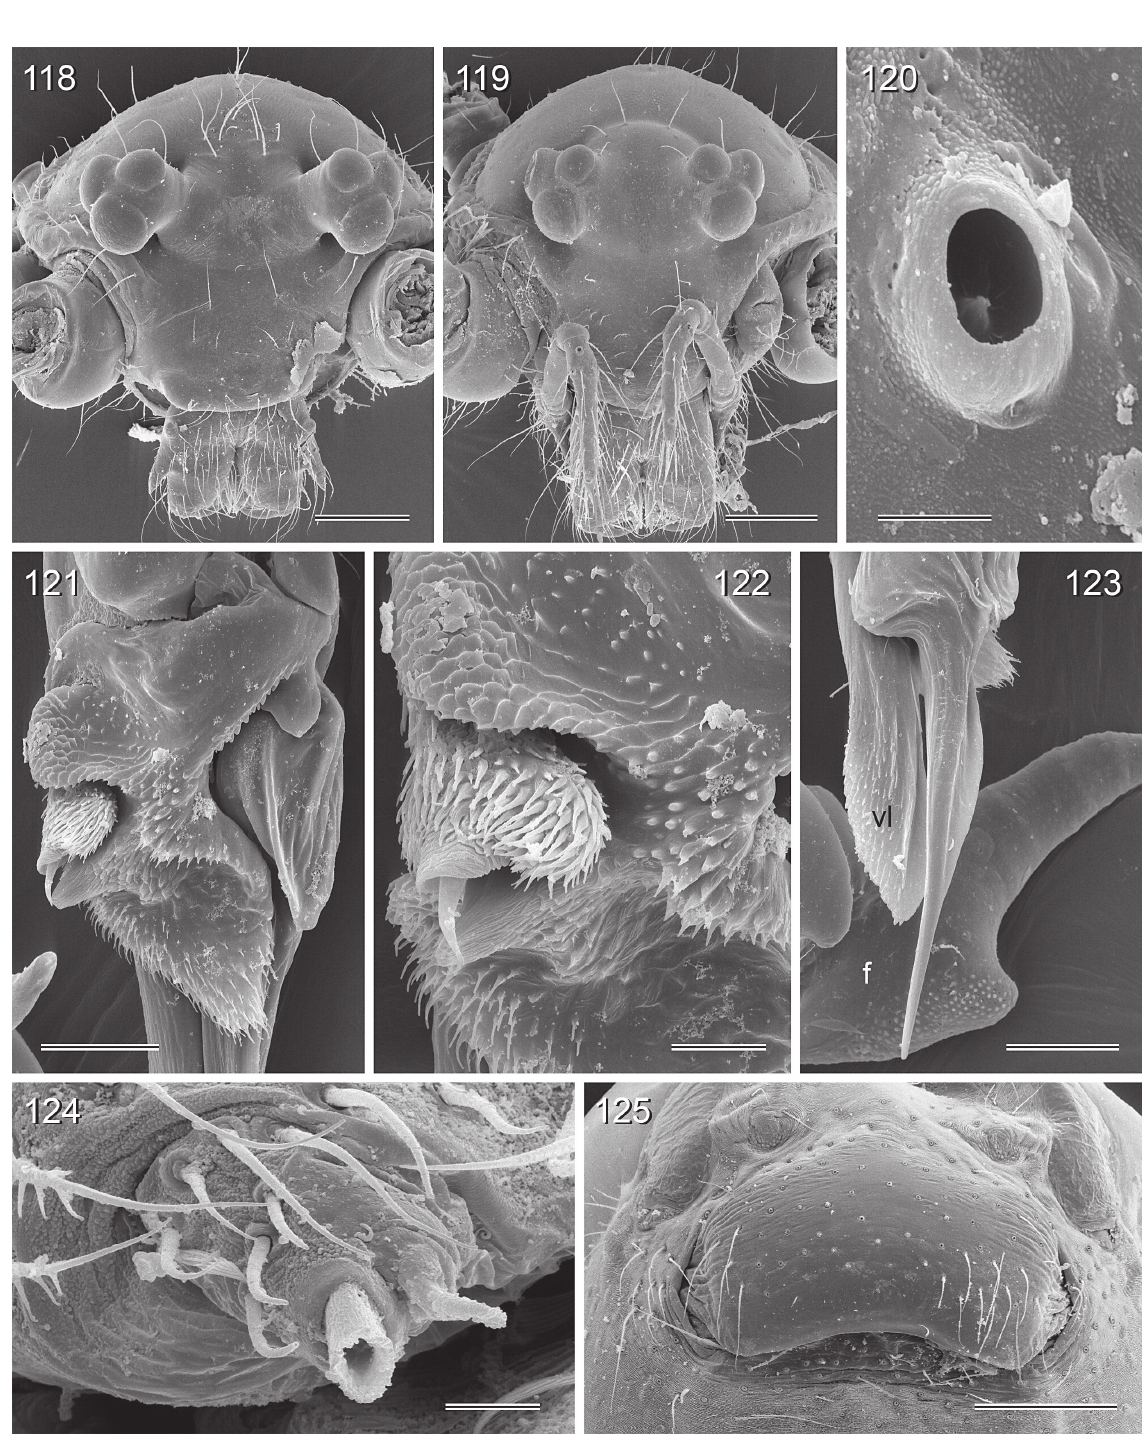
Figs 118–125. Aetana lambir Huber, sp. nov. 118–119. Male and female prosomata, frontal views. 120 . Male palpal tarsal organ. 121 . Left procursus, prolateral view. 122 . Detail of preceding. 123 . Right procursus (and femur apophysis), retrolateral view. 124 . Female ALS. 125 . Epigynum. f = femur; vl = ventral lamina. Scale lines: 118–119, 125 = 200 µm; 120 = 8 µm; 121 = 50 µm; 122 = 20 µm; 123 = 60 µm; 124 = 10